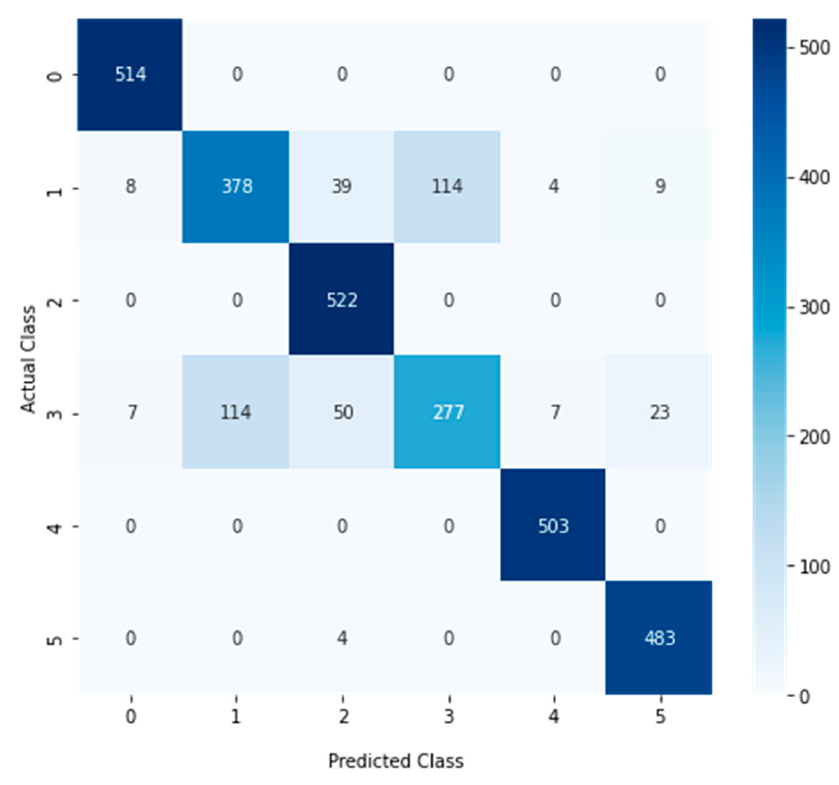
Figure 17. Confusion matrix of the decision tree.